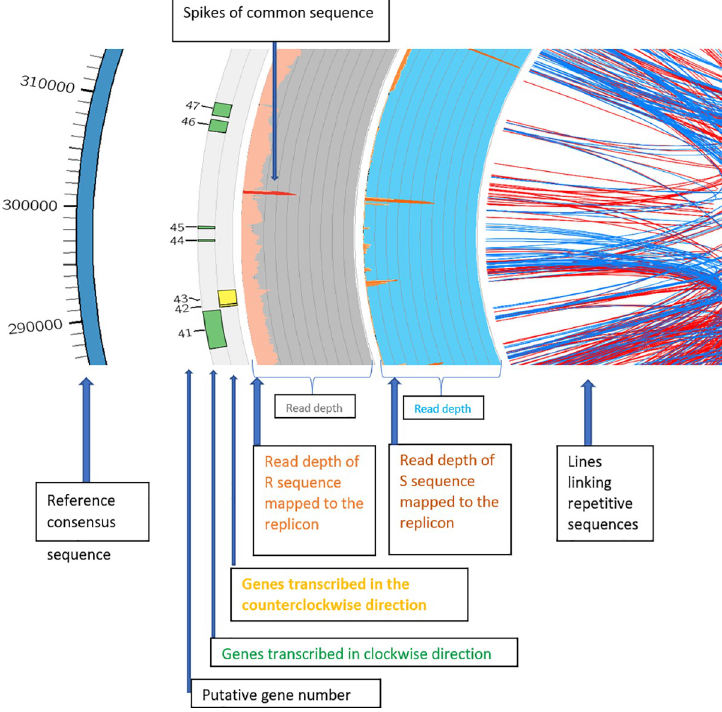
Fig 2. Enlargement of a segment of Fig 1. 300 kb showing a red/orange-colored spike representing regions of high copy numbers relative to the rest of the genome that has been acquired by the EPSPS replicon. The light pink band along the outer edge of the gray track is the read depth for a GR plant and indicates a read depth about 2000 whereas a similar continuous track is not present from sensitive plants. indicated by the color exterior and interior of the center axis of the light gray band, eg. green and exterior is clockwise and yellow and interior is counterclockwise (Fig 1). The next two broad, concentric inner rings, gray and blue, represent the results of WGS sequencing and mapping of read pairs from GR and GS samples from Mississippi to the EPSPS consensus sequence. This approach provided a means to assess representation, contiguity, and variation between the sensitive and resistant biotypes (Fig 1). The gray and blue concentric rings are graphic representations of read depths up to ~8,000 reads covering certain bases. The light orange glyph (along outer edge of gray circle) against the gray background depicts read depths from GR plants. Dark orange indicates bases that are covered by greater than 2,000 reads. The glyphs along the outer edge of the blue track are incomplete indicating gaps in sequence for reads from sensitive plants. The read depth in GR confirmed the presence of a contiguous cir- cular replicon sequence and the lack of contiguous sequence in GS (Fig 1). The red/orange spikes in both tracks are areas of higher read depth represent sequences common to both genomes, possibly originating from low-complexity sequence, repetitive elements, or other high copy number DNAs present in higher abundance in the genome (Figs 1 and 2). These spikes may indicate that the replicon is a re-arranged assembly of the GS genome because of the lack of similar read pair alignments from the GS WGS datasets. The central core of Fig 1 shows red and blue links of repetitive sequences. The EPSPS gene was surrounded by dense concentrations of tandem repeats (indicated by the red line links) which align to putative gene sequences that were not found clustered in S plants (Fig 1). The tandem repeats flanked the EPSPS gene, but largely excluded the inverted repeats (indicated